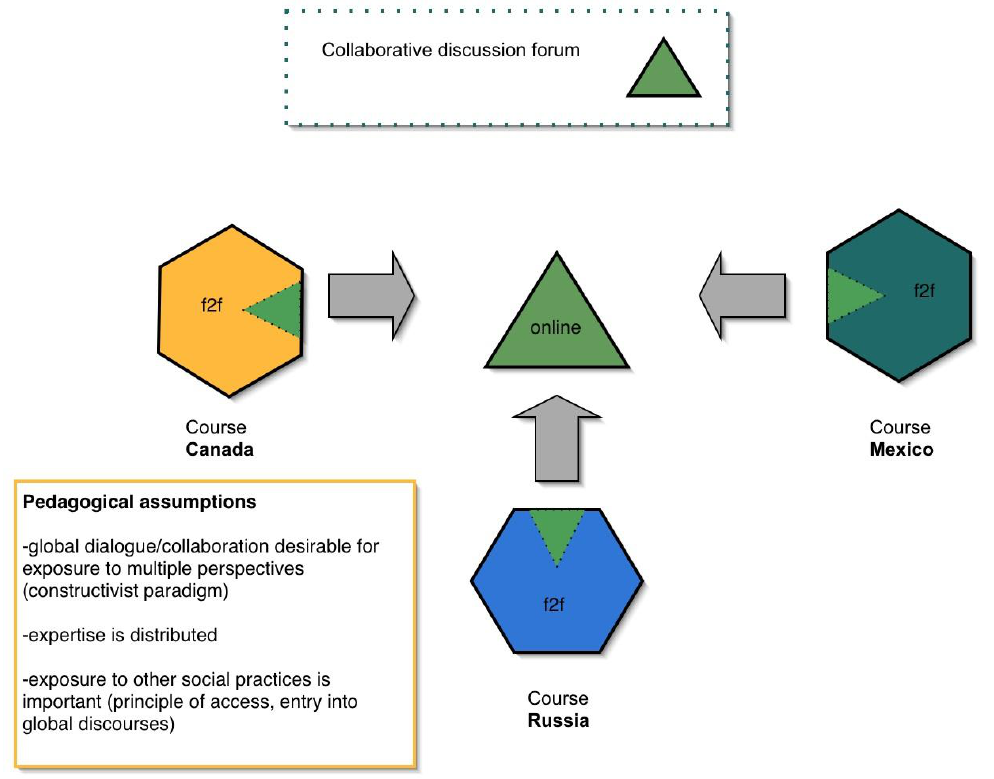
Figure 3. Mexico/Canada/Russia implementation of the open